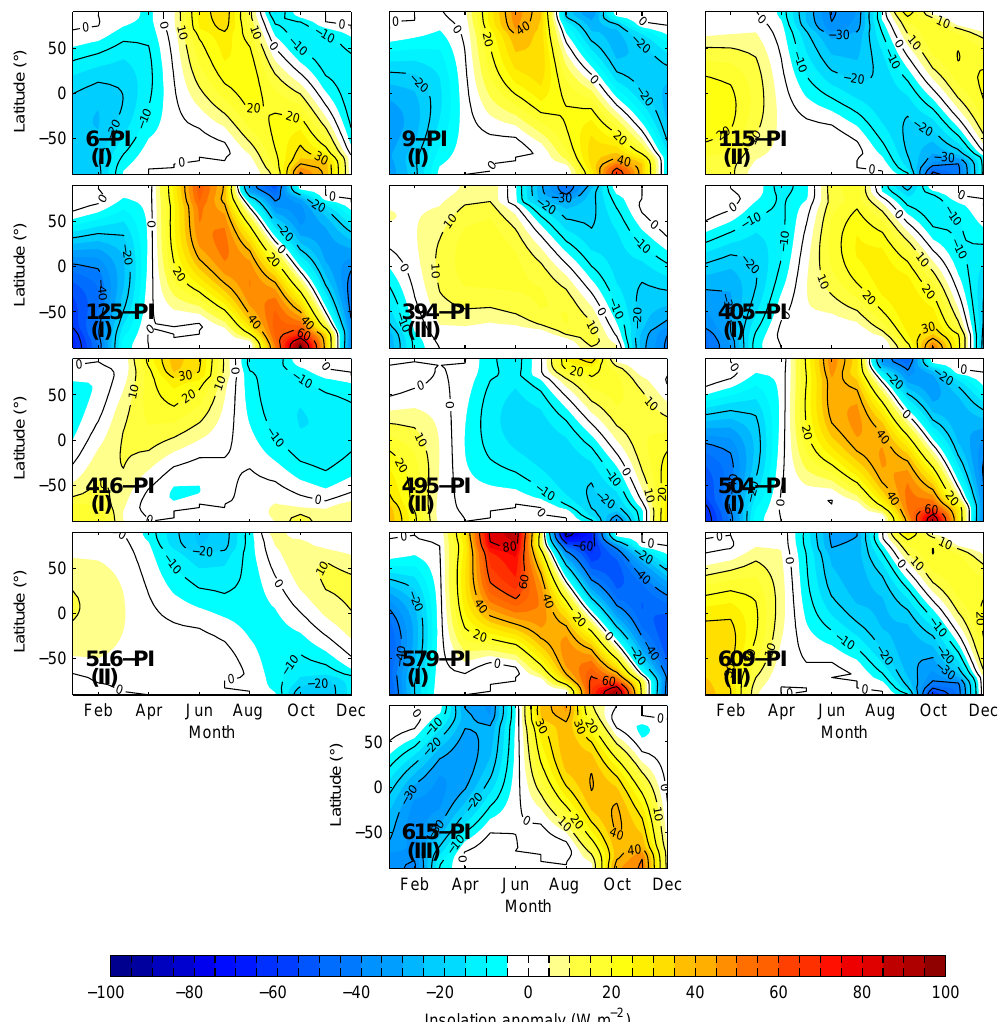
Figure 2. Insolation anomalies (relative to PI) for the time slices simulated in this study. Patterns of insolation anomaly are classified as Groups I, II, and III (see text). The calculation assumes a fixed present-day calendar with vernal equinox on 21